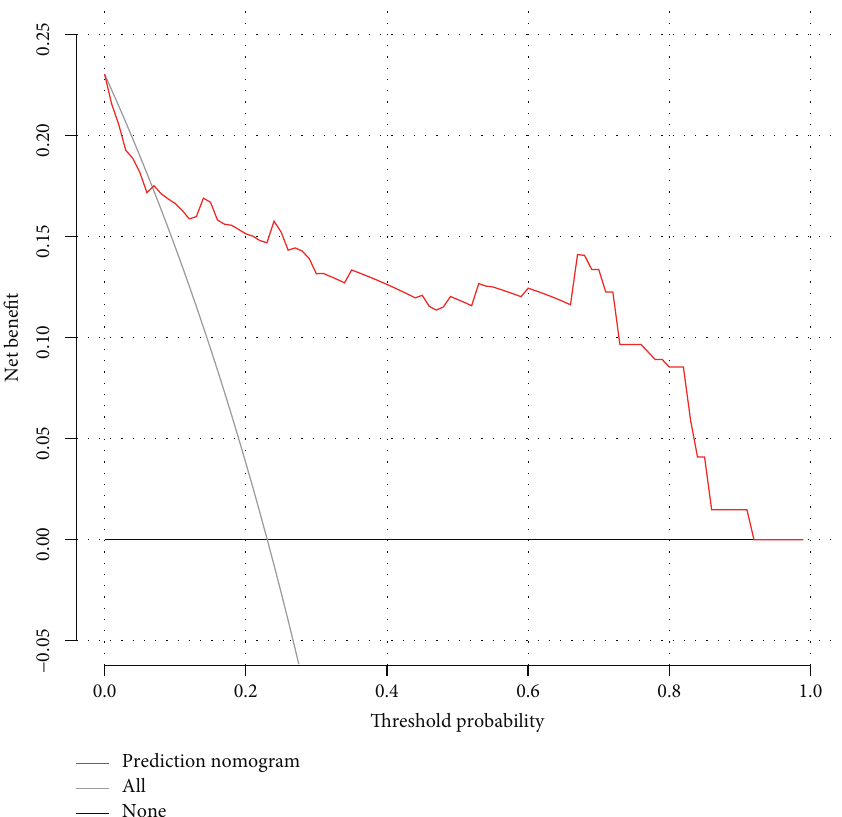
Figure 6: Decision curve analysis for the untreated nomogram. The y -axis measures the net benefit. The red line represents the medication untreated risk nomogram. The thin solid line represents the assumption that all patients are nontreatment to medication. Thin thick solid line represents the assumption that no patients are nontreatment to medication. The decision curve showed that if the threshold probability of a patient ranges from 7% to 91%, using this untreated nomogram in the current study to predict medication nontreatment risk adds more benefit than the intervention-all-patients scheme or the intervention-none